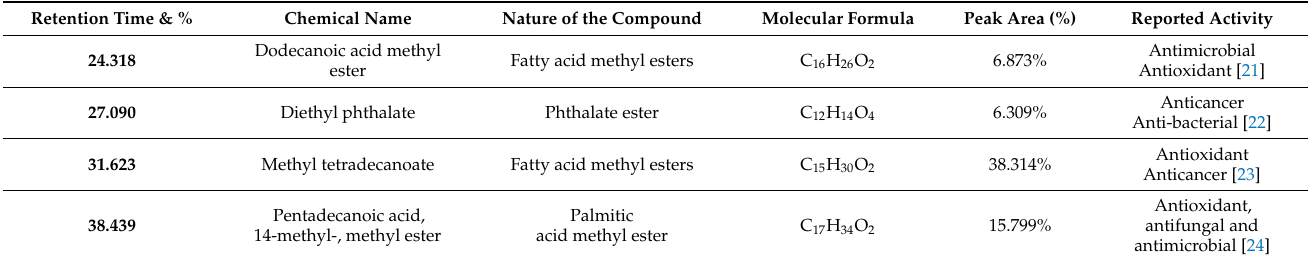
Figure 14. GC-MS chromatogram of hexane fraction of C. minima . Table 8. Active compounds identified in the hexane fraction of C. minima by GC-MS